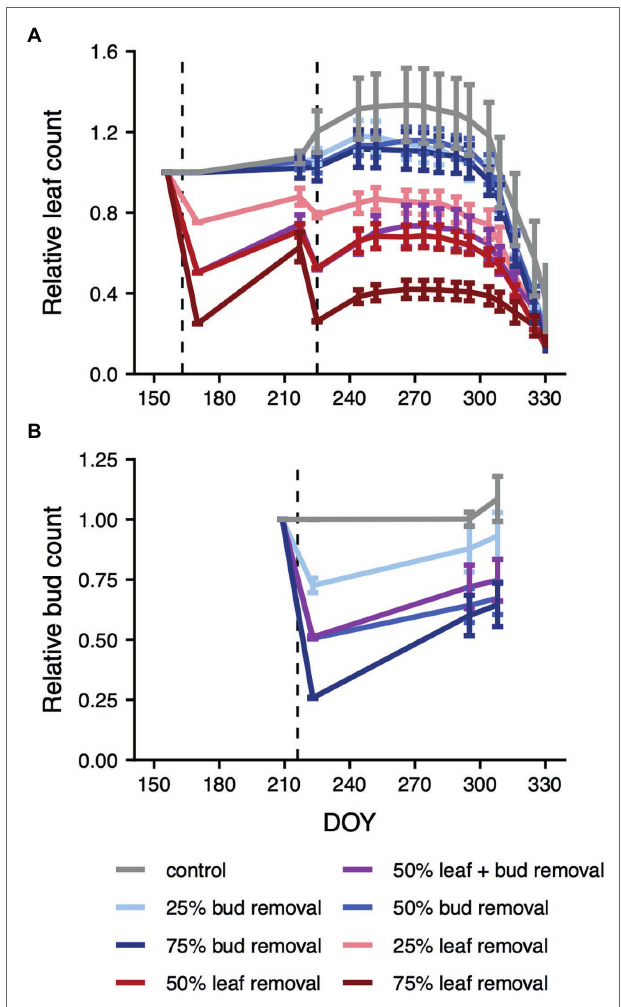
FIGURE 1 | Mean relative leaf and bud counts by treatment over time. The dashed lines mark the DOYs of the leaf (A) and bud (B) removals. The relative (leaf or bud) count is defined as the ratio of the current count to the count just before the first respective plant organ removal. For the purpose of visualization, we plotted both the first two leaf and bud count measurements 14 days apart from each other, despite them having happened on the same day right before and after the respective plant organ removal. Measurements done over several days were assigned to the first day of the measurement interval. Error bars mark the area of ±1 standard error around the mean. A graph of absolute leaf and bud counts is depicted in Supplementary Figure 2 .